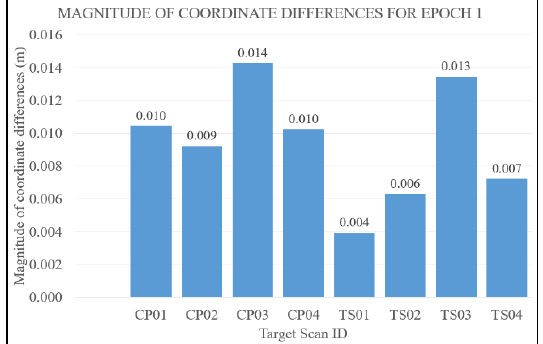
Figure 43. The magnitude of coordinate differences between TLS and Total Station data (Epoch 1)